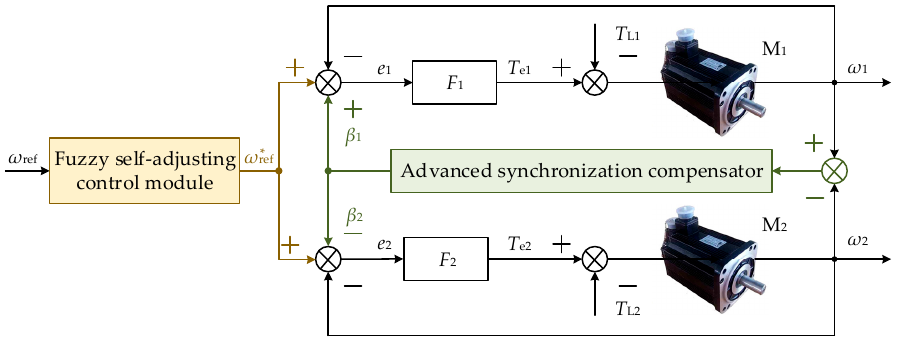
Figure 3. Fuzzy self-adjusting cross-coupling control structure.